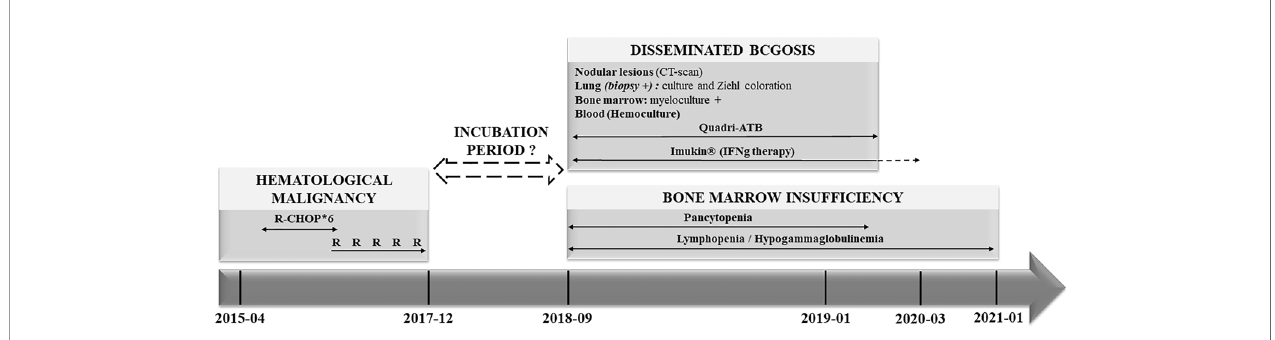
FIGURE 1 | Clinical history (Timeline). R, Rituximab; CHOP: C, cyclophosphamide; H, hydroxyadriamycine; O, oncovin ® ; P, prednisone; CT, computerized tomography; ATB,